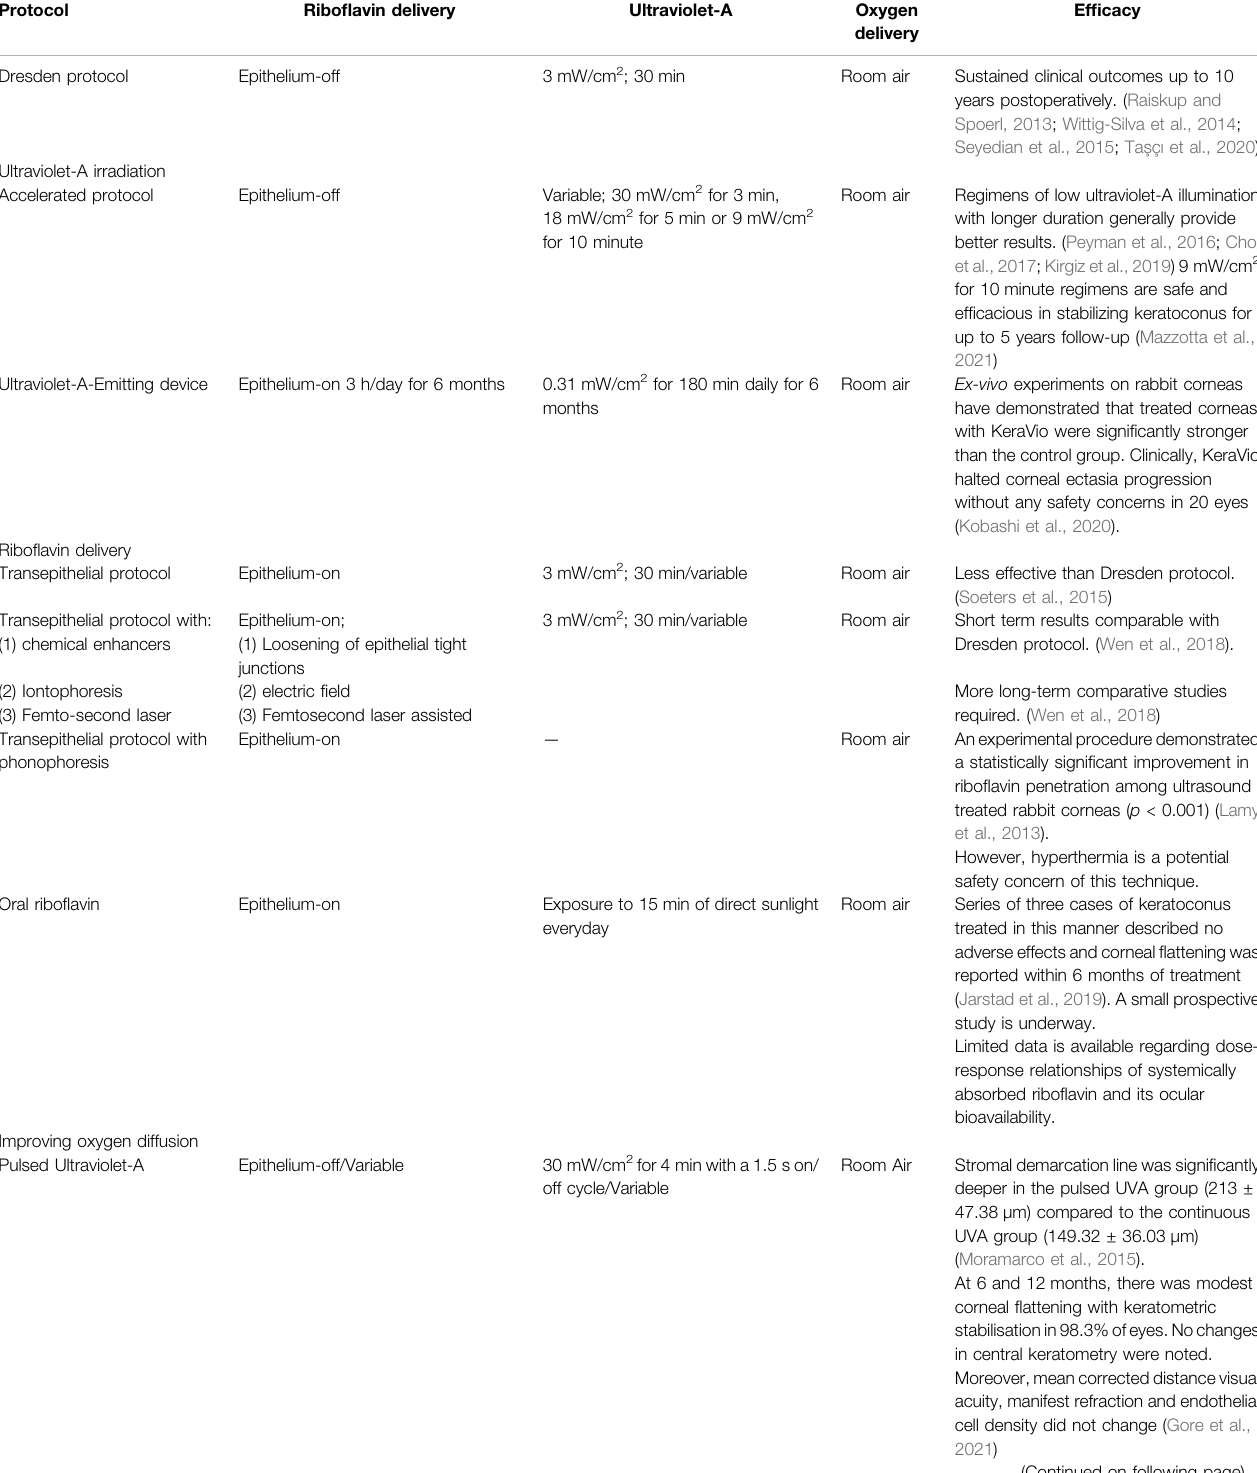
TABLE 1 | Summary of existing corneal cross-linking